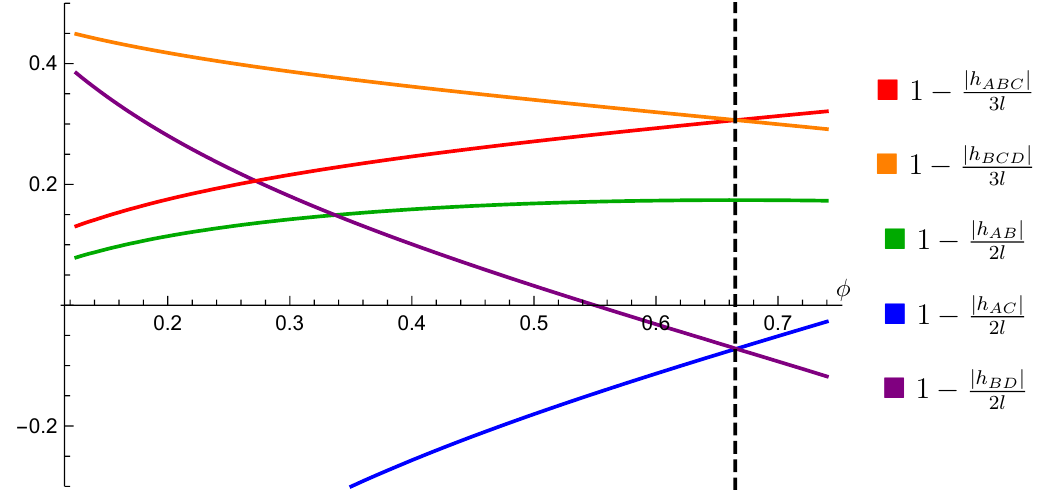
Figure 4 . The constraints (3.7) in the subspace where the connected and disconnected actions are equal. The dashed line indicates the point with the additional (cid:25)= 2 rotational symmetry discussed above.